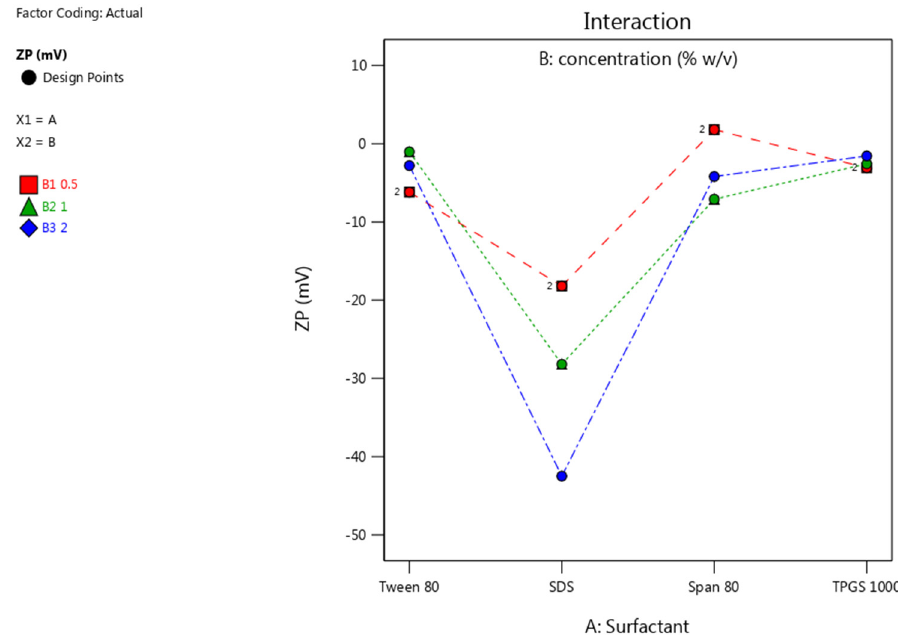
Figure 7. ZP of nano co-crystals using different surfactants at concentrations of 0.5% w/v (red), 1% w/v (green) and 2% w/v (blue).